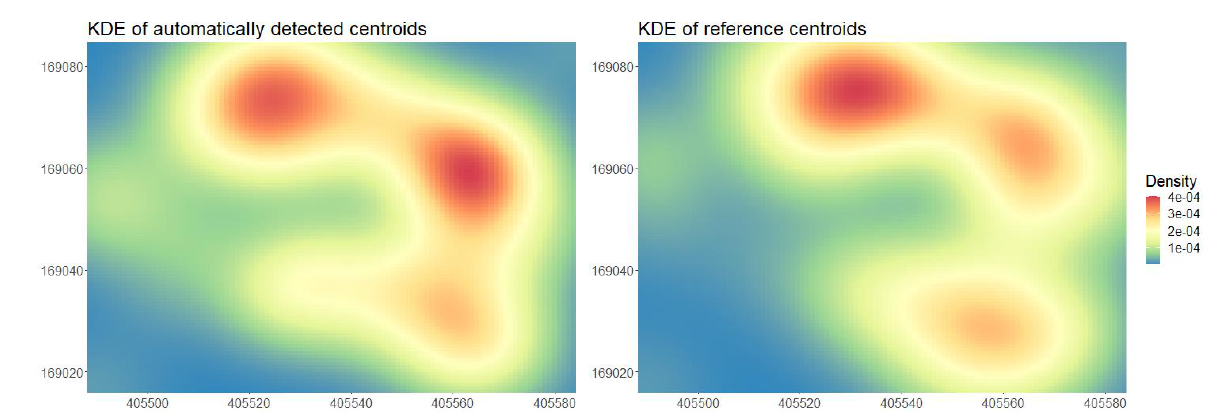
Figure 8. Kernel density estimation (KDE) of the stem centroid positions obtained via automatic detection and reference data on the exemplary sample site Frohn_02. Coordinates are in meters and in the “MGI / Austria GK M31” coordinate reference system (EPSG -code: 31258).